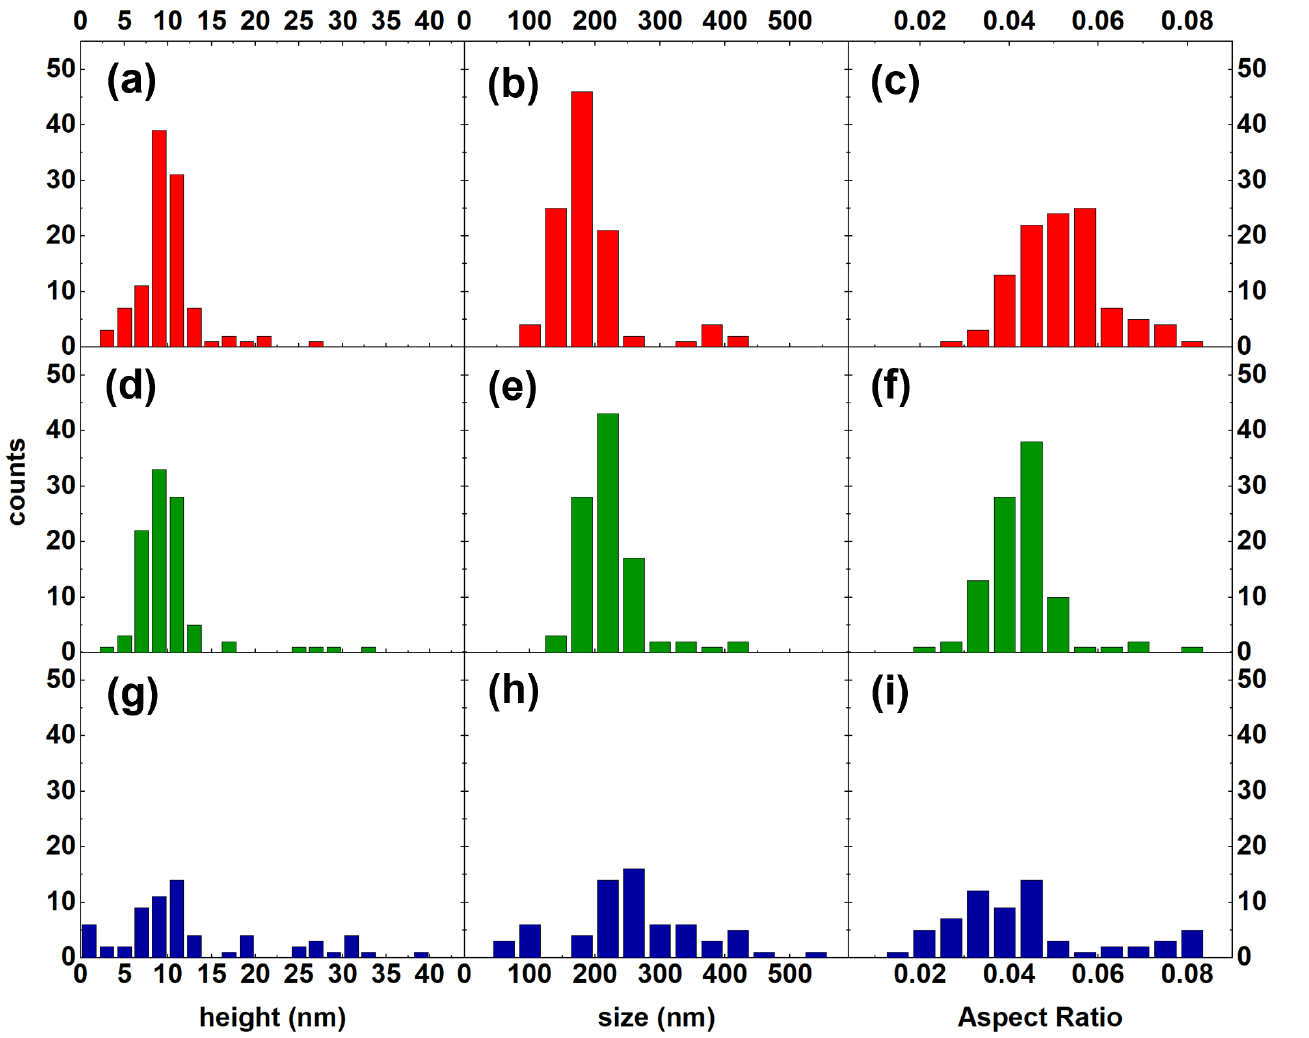
Figure 3. ( a ) Height, ( b ) lateral size, and ( c ) aspect ratio distributions relative to Sample S1 (no capping); ( d ) height, ( e ) lateral size, and ( f ) aspect ratio distributions relative to Sample S2 (5 nm capping); ( g ) height, ( h ) lateral size, and ( i ) aspect ratio distributions relative to Sample S3 (10 nm